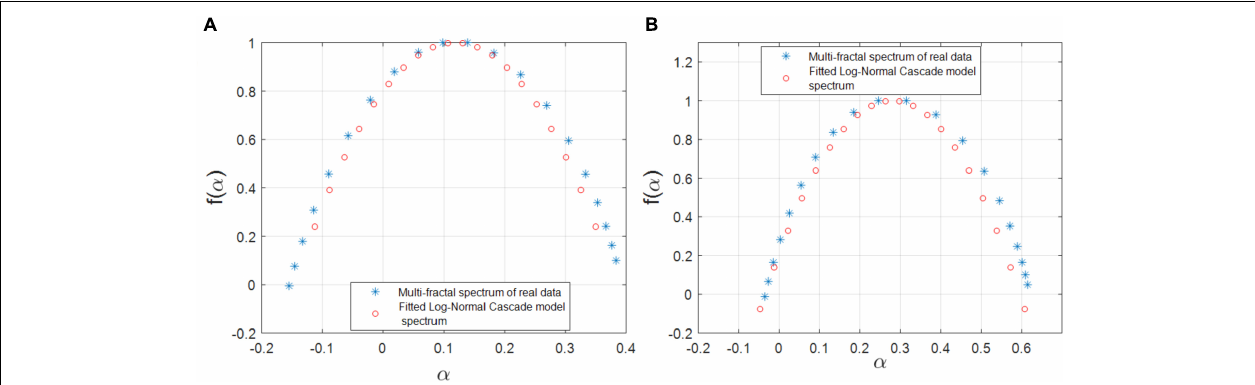
FIGURE 5 | (A) The multifractal spectrum of a cross-dependency (link) between the gene regulatory network of E. coli (soxR and soxS genes) that can best be fitted by the log-normal cascade multifractal model. (B) The multifractal spectrum of a cross-dependency (link) between the gene regulatory network of S. cerevisiae (YKL032C and YKL043W genes) that can best be fitted by the log-normal cascade multifractal model.